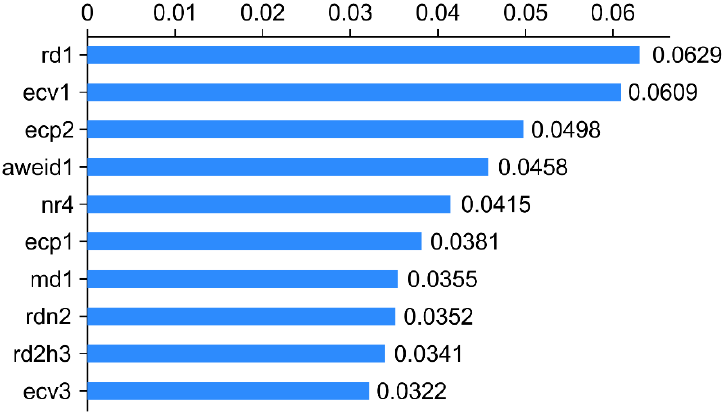
Figure 3. Importance of features for the ten variables in eXtreme Gradient classification.